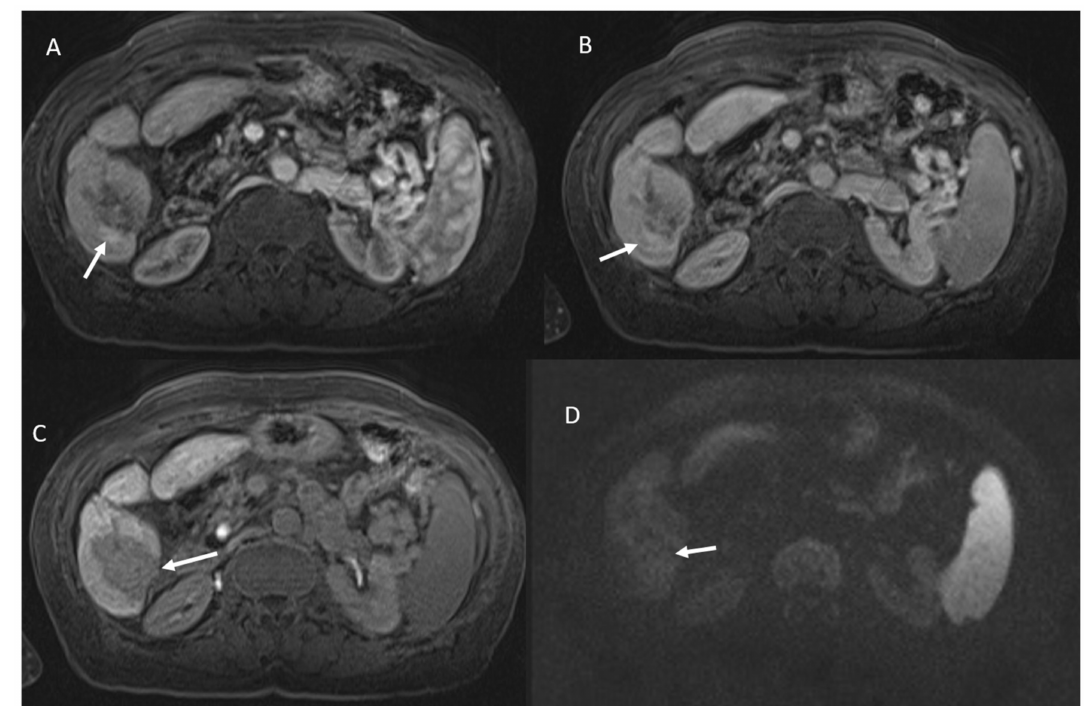
Figure 1. Vascular shunt in HCC treated patient. During contrast the arrow shows APHE in arterial phase ( A ), without